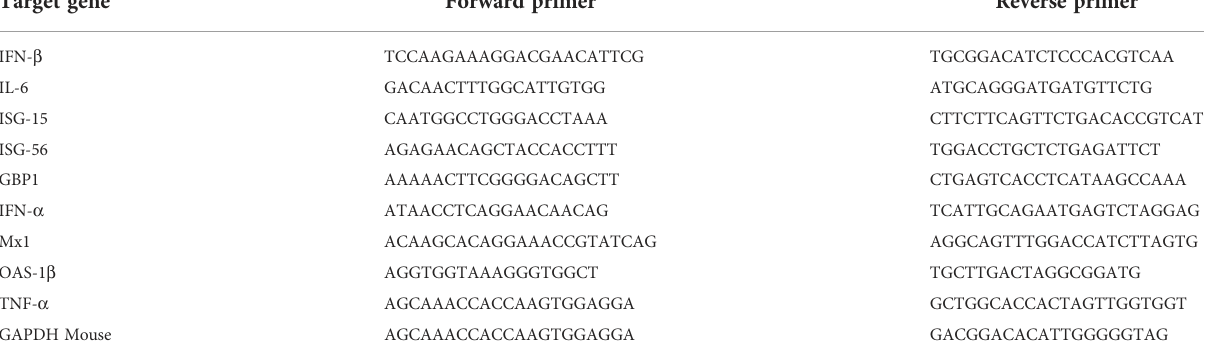
TABLE 1 The primer sequences for the genes used in real-time PCR. Target